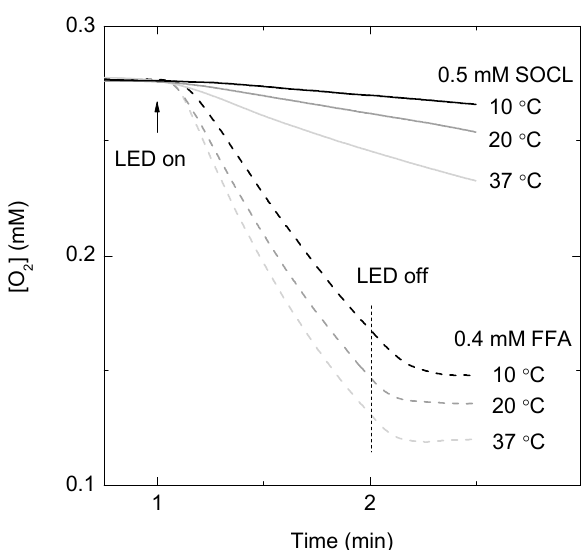
Figure 1. Molecular oxygen uptake in the oxygen electrode chamber containing 2 µ M methylene blue as 1 O 2 photosensitizer and 0.5 mM Singlet Oxygen Chemiluminescence probe (SOCL), solid lines, or 0.4 mM furfuryl alcohol (FFA), dashed lines, as 1 O 2 quenchers in phosphate buffer saline pH 7.4 at three different temperatures. Samples were illuminated with a red light-emitting diode (LED) source with an intensity of 2 mE m − 2 s − 1 for 1 min or 2 min, depending whether FFA or SOCL were present in the reaction mixture, respectively. The photo-oxygenation reactions were performed under atmospheric pressure conditions.